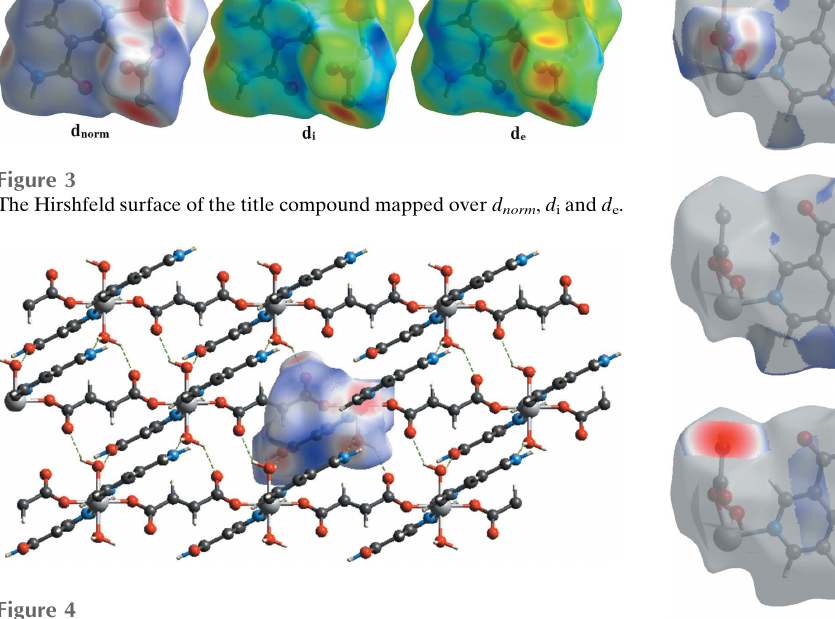
Figure 4 Hirshfeld surfaces mapped over d norm to visualize the intermolecular interactions of the title compound. mapped over a fixed colour scale of (cid:4) 1.219 (red) to 1.466 (blue) a.u.